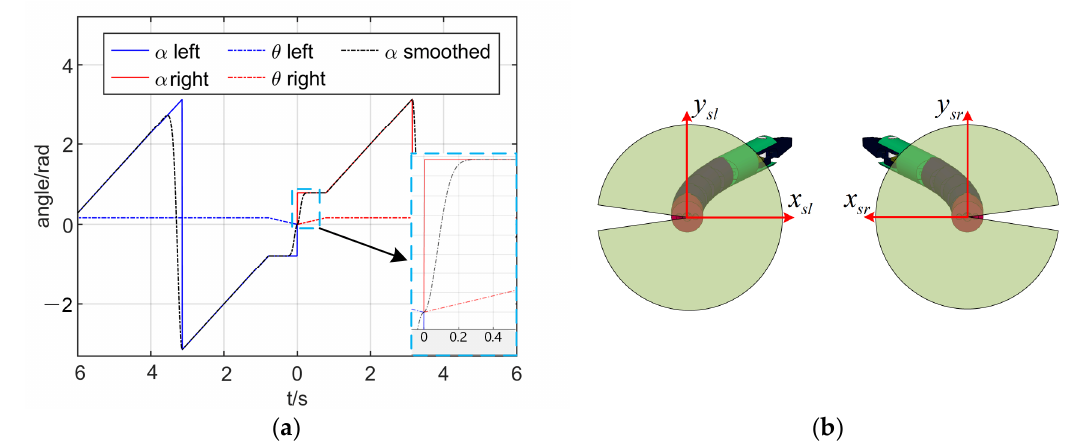
Figure 9. ( a ) Original joint trajectory and smoothed joint trajectory; ( b ) schematic diagram in two- manipulator collaboration mode. The green area indicates the range of the rotation angle.